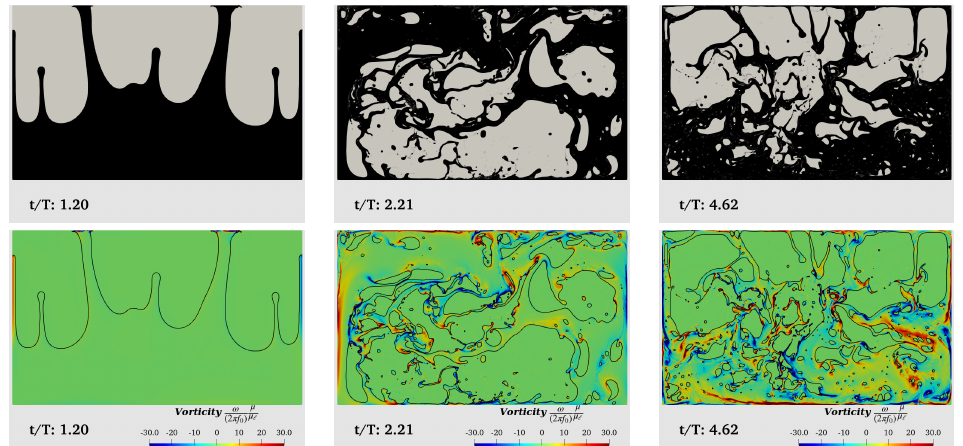
Figure 17. Two-dimensional oil E LEMENTAL ® results on the N 200 resolution at various time instants. The ( top ) row shows the VOF with oil black and air white. The ( bottom ) row shows the non- dimensionalized vorticity.